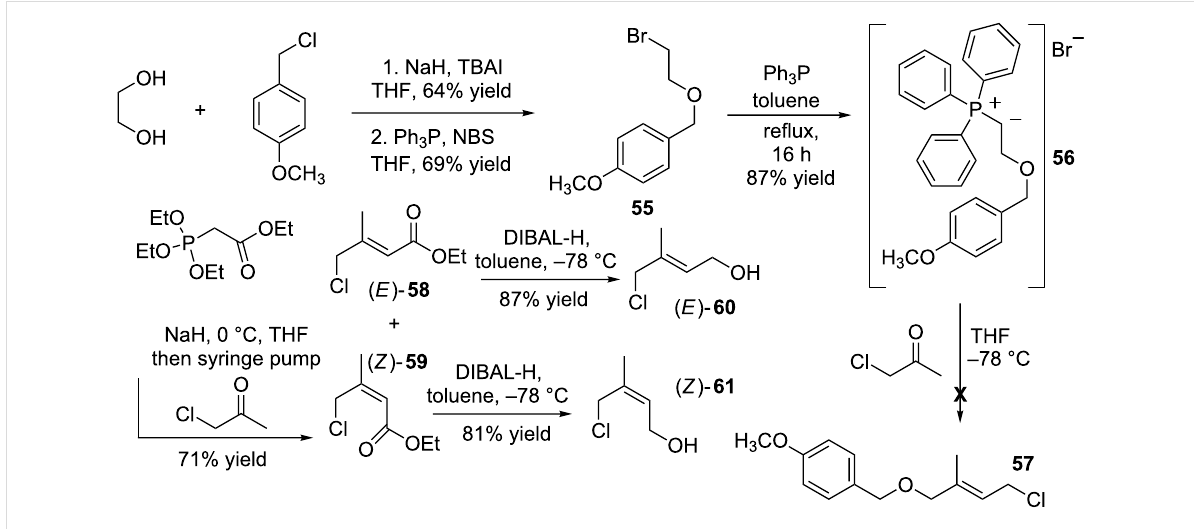
Scheme 8: Synthesis of ( E )-3-methyl-4-chlorobut-2-en-1-ol (( E )- 60 ) and ( Z )-3-methyl-4-chlorobut-2-en-1-ol (( Z )- 61